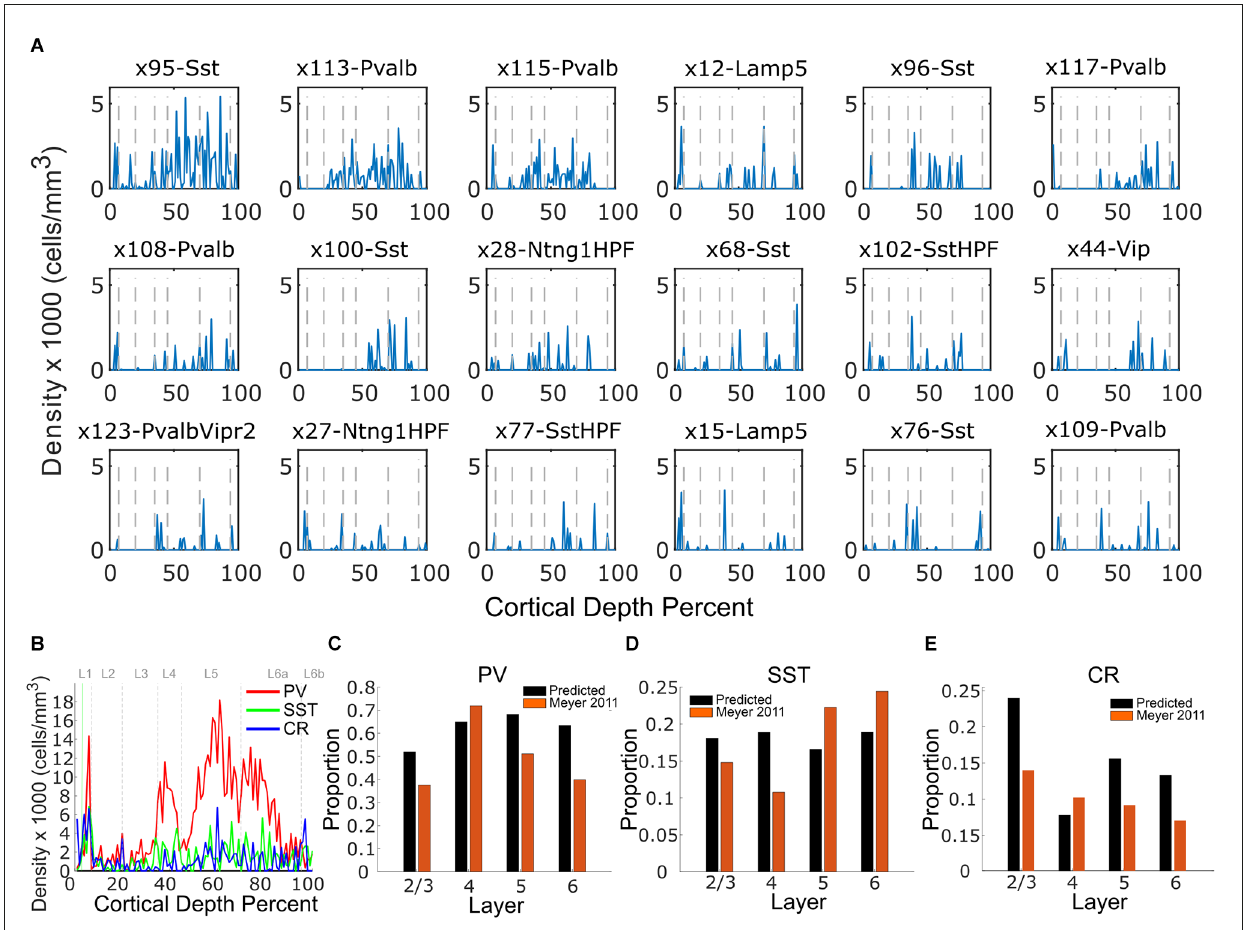
FIGURE4 Inhibitory neuron predictions. (A) Predicted expression of inhibitory cell types as a function of percent cortex depth (blue traces), shown for the most frequent interneuron types. (B) Average density of parvalbumin (PV; red), somatostatin (SST; green), and calretinin (CR; blue) expressing cells. (C) Layer-dependent inhibitory composition comparison against the literature (Meyer et al., 2011) for PV. (D) Comparison for SST. (E) Comparison for CR. In all density plots, layer boundaries for L1, L2, L3, L4, L5, L6a, and L6b are indicated by the dashed gray